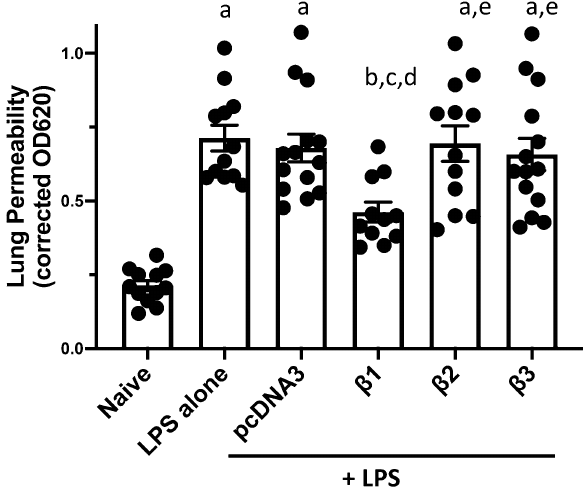
Figure 5. Electroporation mediated gene transfer of the β1, but not the β2 or β3, subunit of the Na + ,K + -ATPase attenuates LPS increased lung permeability in mice. Lung injury was established in C57B6 mice (n = 11–14) followed 1 day later by gene transfer as described in Fig. 2. Forty-seven hours after gene transfer, Evans Blue Dye (30 mg/kg) was administered by tail vein injection and one hour later, lungs were perfused with PBS and harvested for dye extraction. Lung permeability was evaluated by quantifying the absorbance of extracted Evans Blue Dye and shown as mean ± SEM. All experiments were carried out three times and a representative experiment is shown. One-way ANOVA with post-hoc Tukey’s multiple comparisons was used for statistical analysis; a, p < 0.0001 compared to naïve; b, p < 0.01 compared to naïve; c, p < 0.01 compared to LPS alone; d, p < 0.05 compared to LPS + pcDNA3; e, p < 0.05 compared to LPS + β1.